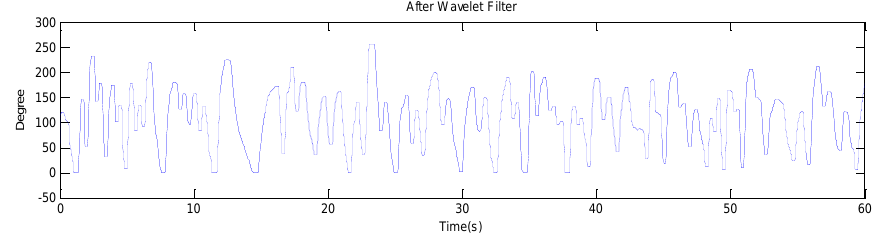
Figure 18. Abnormal breathing pattern after filtration.